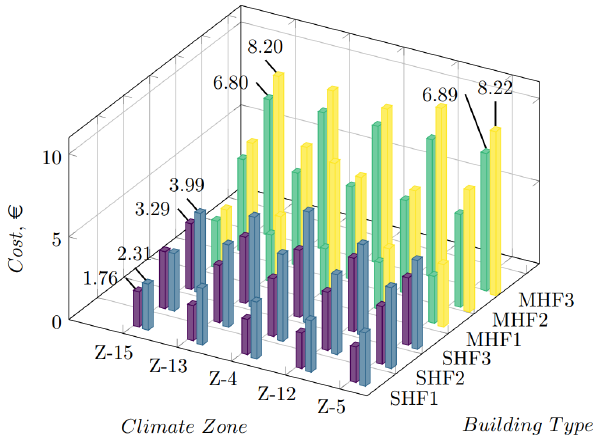
Figure 13. Cost comparison between full-load (left column, purple and green) and partial-load operation (right column, blue and yellow) for different climate zones and building types, for an SWX typical day (summer, working day, neutral weather).